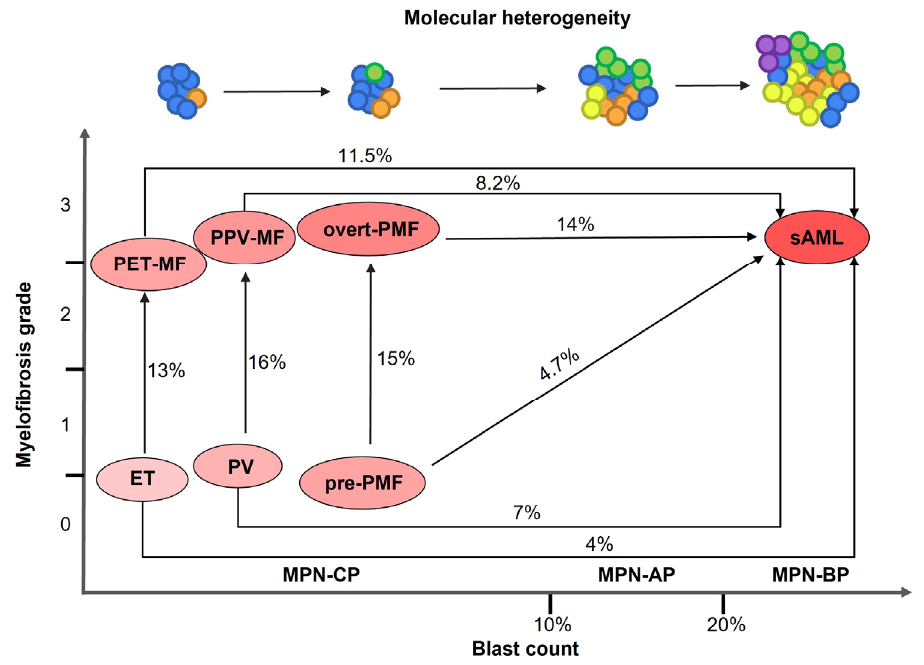
Figure 1. Routes of disease progression and evolution in MPNs. Owing to overlapping clinical features, different disorders belonging to the MPN family can evolve into one another. State transitions can be defined based on the degree of bone marrow fibrosis and/or the frequency of blasts in peripheral blood and bone marrow. Disease evolution is associated with increasing molecular heterogeneity. Percentages represent the observed frequency of disease progression and evolution in MPN patients. Shades of red represents disease aggressiveness. ET: Essential Thrombocythemia; PV: Polycythemia Vera; pre-PMF: pre-fibrotic Primary Myelofibrosis; PET-MF: post-ET Myelofibrosis; PPV-MF: post-PV Myelofibrosis; sAML: secondary Acute Myeloid Leukemia; MPN: Myeloprolifertive Neoplasm; MPN-CP: MPN chronic phase; MPN-AP: MPN accelerated phase; MPN-BP: MPN blast phase.